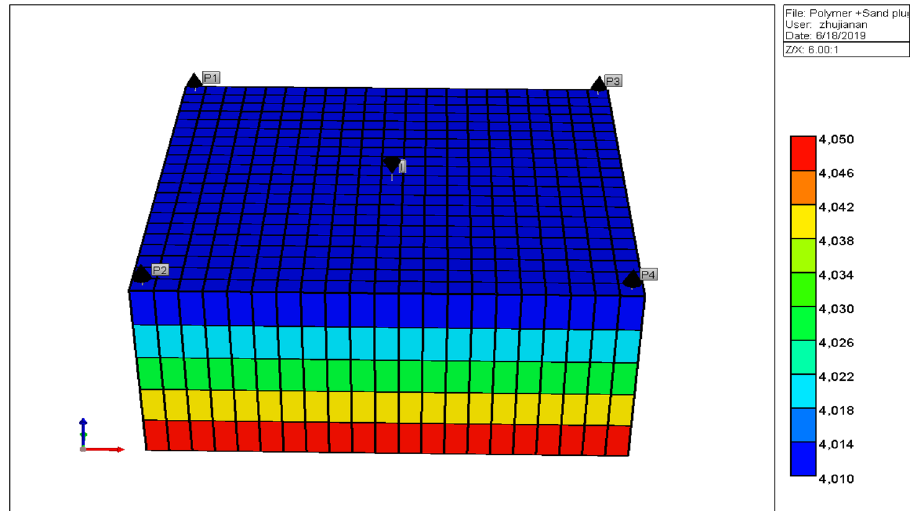
Figure 1. 3D model of inverted five (5) spot pattern polymer flooding model CMG STARS 2017.10 URL: https:// www. cmgl.